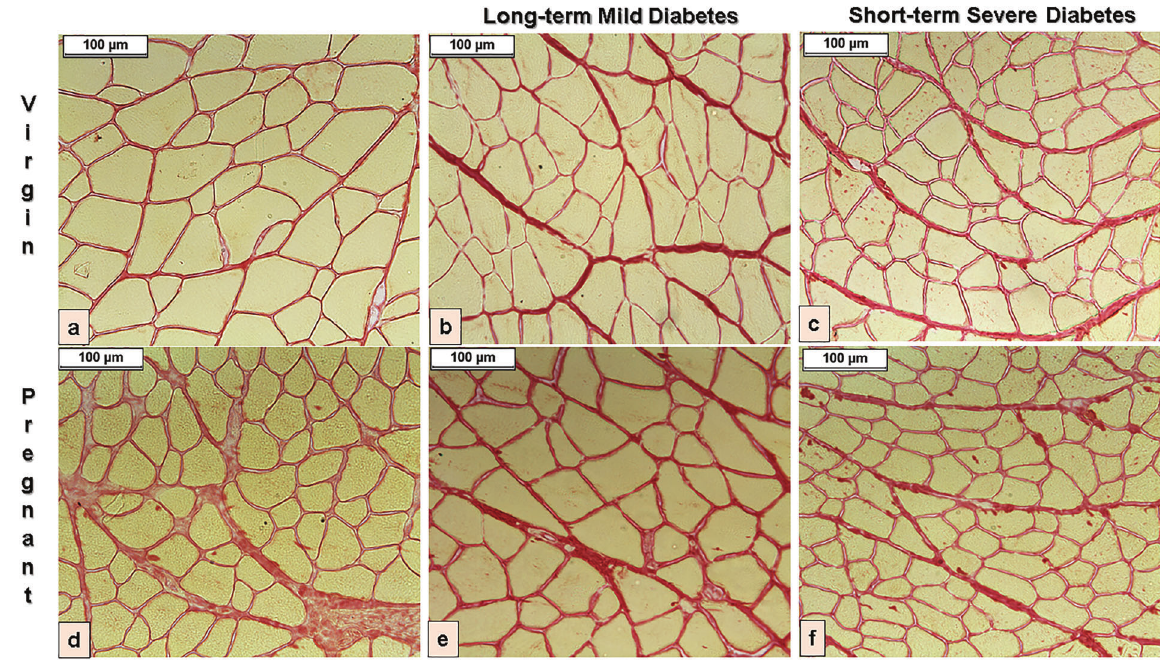
Figure 2. Photomicrographs of rat rectus abdominis after picrosirius red staining of striated muscle (yellow) and collagen (red). Virgin ( a ), long-term mild diabetic ( b ), short-term severe diabetic ( c ), pregnant ( d ), long-term mild diabetic pregnant ( e ), and short-term severe diabetic pregnant ( f) . Magni fi cation 20 (cid:1)